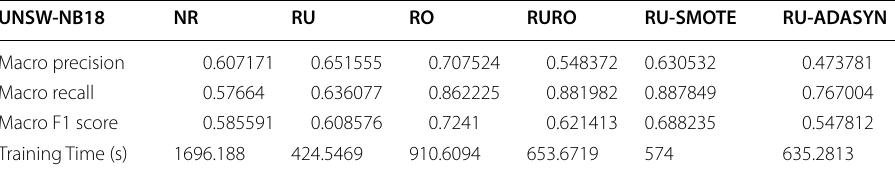
Table 30 ANN classification results for UNSW-NB18 (BoT-IoT) on local machine for various resampling methods